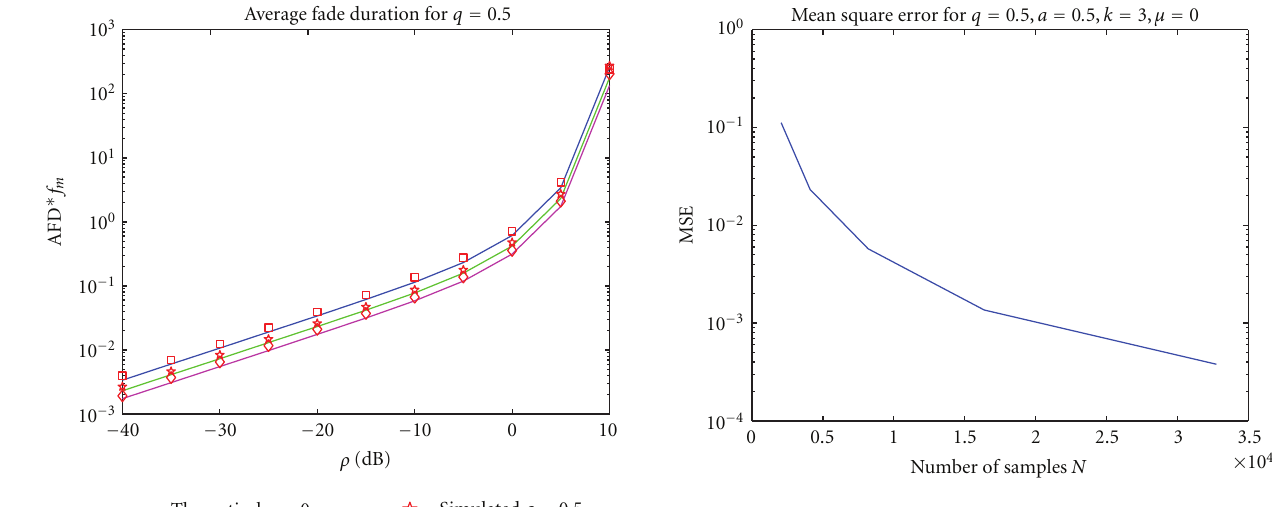
Figure 16: Mean square error of autocorrelation function q = 0 . 5, a = 0 . 5, k =